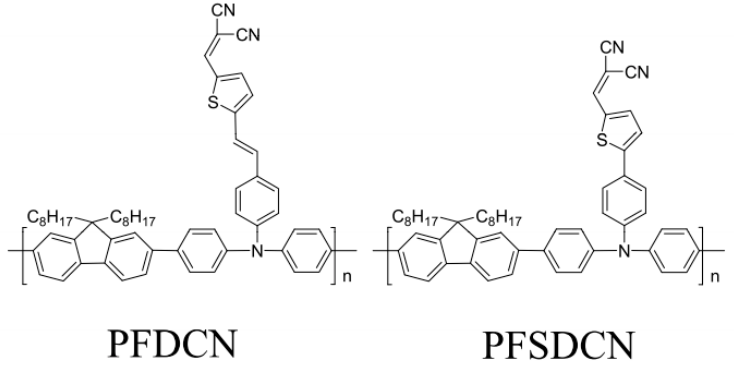
Figure 8. Chemical structures of PFDCN and PFSDCN.